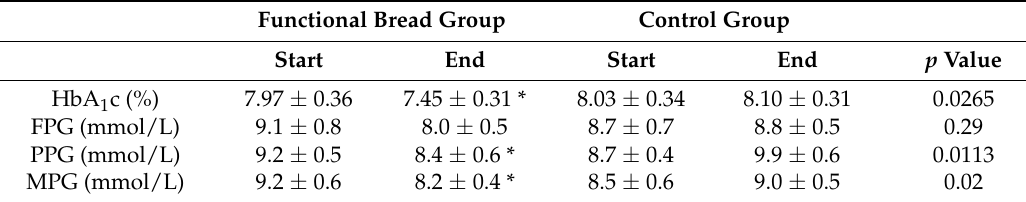
Table 3. Hemoglobin A 1 c (HbA 1 c) (as percent, %), fasting plasma glucose (FPG), post-prandial plasma glucose (PPG) and mean plasma glucose (MPG), in the ‘functional bread’ and in the ‘control’ treatment groups, before (‘start’) and after (‘end’) the observation periods. Data are expressed as means ± SE. Functional Bread Group Control Group